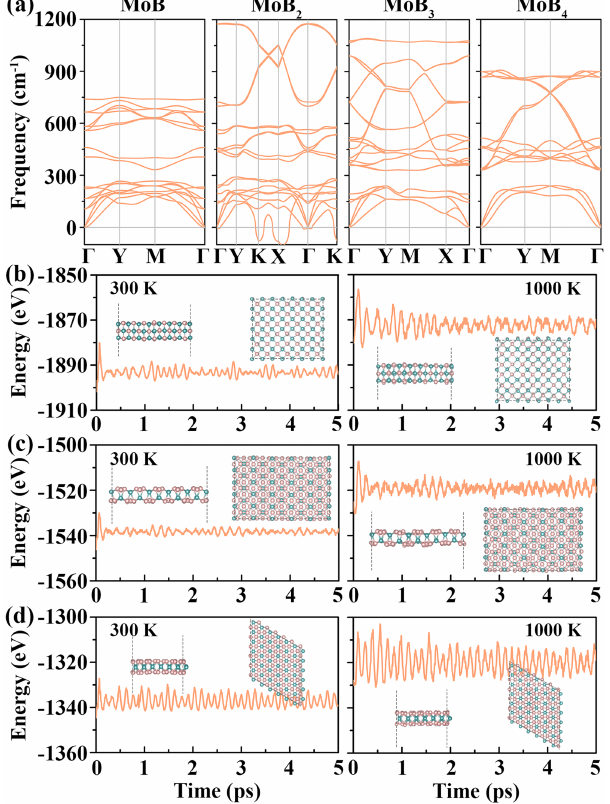
Fig. 2 Stability. a Phonon spectra of the MoB x ( x = 1, 2, 3, and 4) monolayers. Total energies during the AIMD simulations of the b MoB, c MoB 3 , and d MoB 4 monolayers at 300 and 1000 K with top and side views of the fi nal structures.